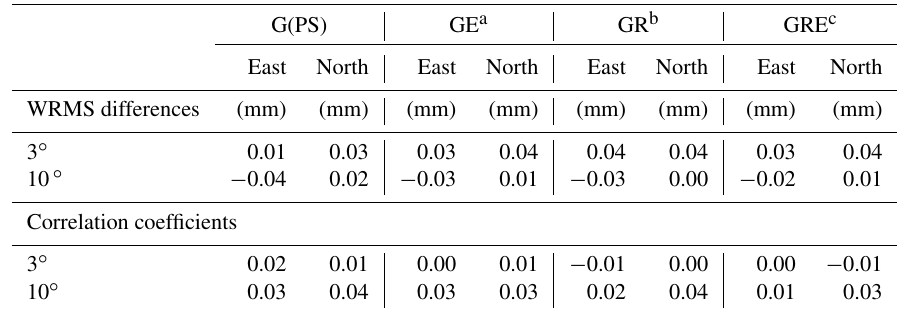
√ √ − 1 − 1 h relative to 0.3mm h (in Table 3).